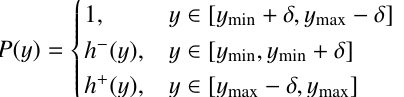
Figure 1. The e ff ects of the interaction of propagating waves without smoothing at t =